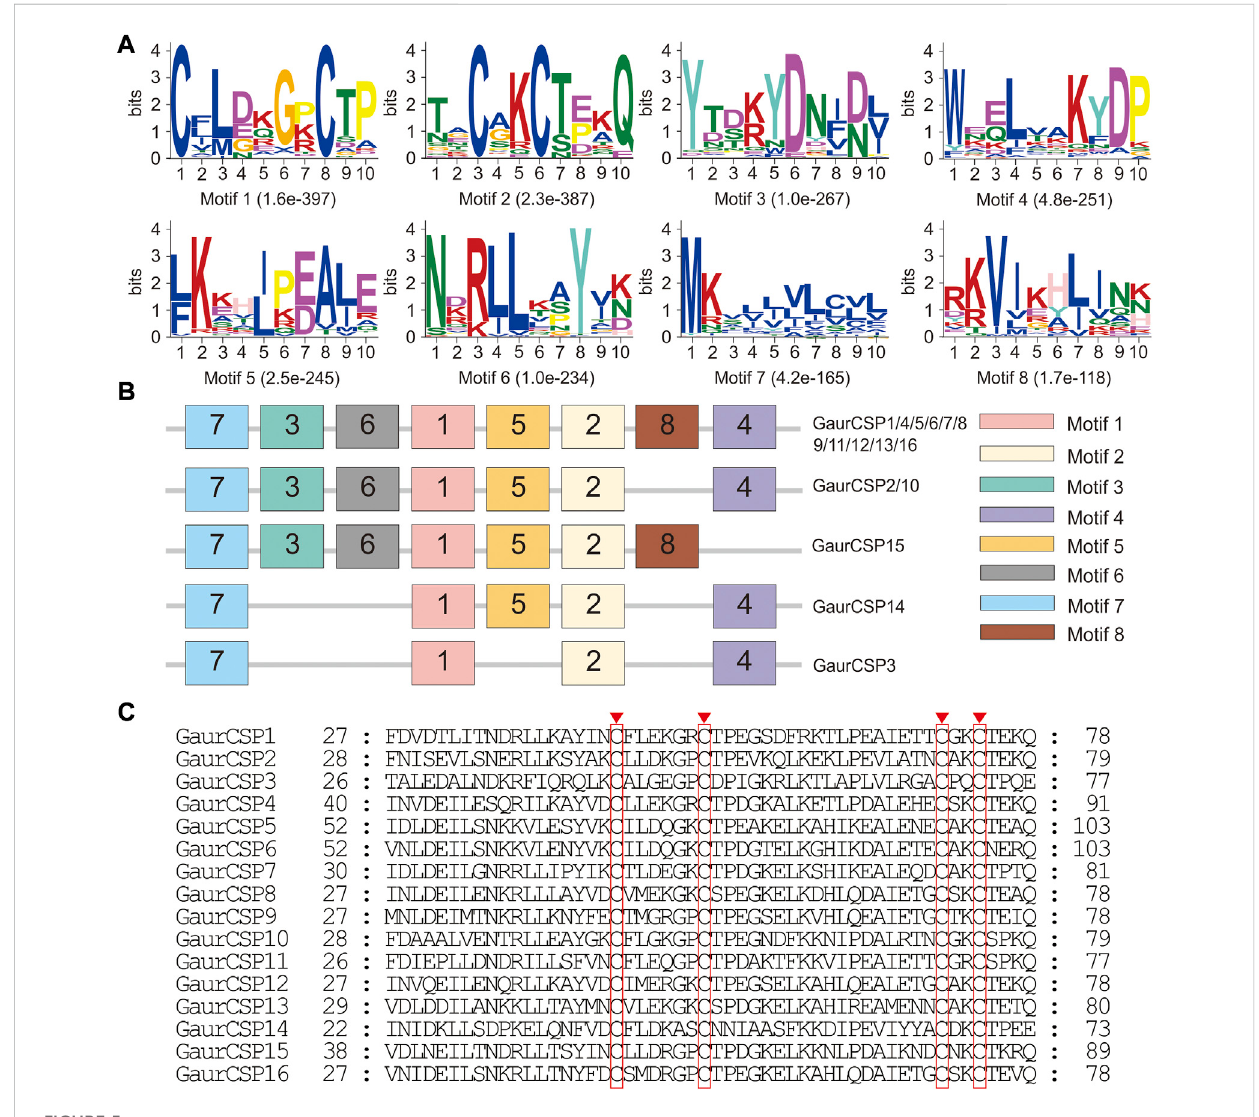
FIGURE 5 Motif pattern analysis and alignment of candidate chemosensory proteins (CSPs) of Gynaephora aureata . (A) Eight motifs from G. aureata and other lepidopterans.The E -valueforeachmotif isshowninparentheses. (B) Locationsofeachmotifintheproteinsequences. (C) AlignmentofcandidateCSPs of G. aureata . The highly conserved cysteine residues are marked with red